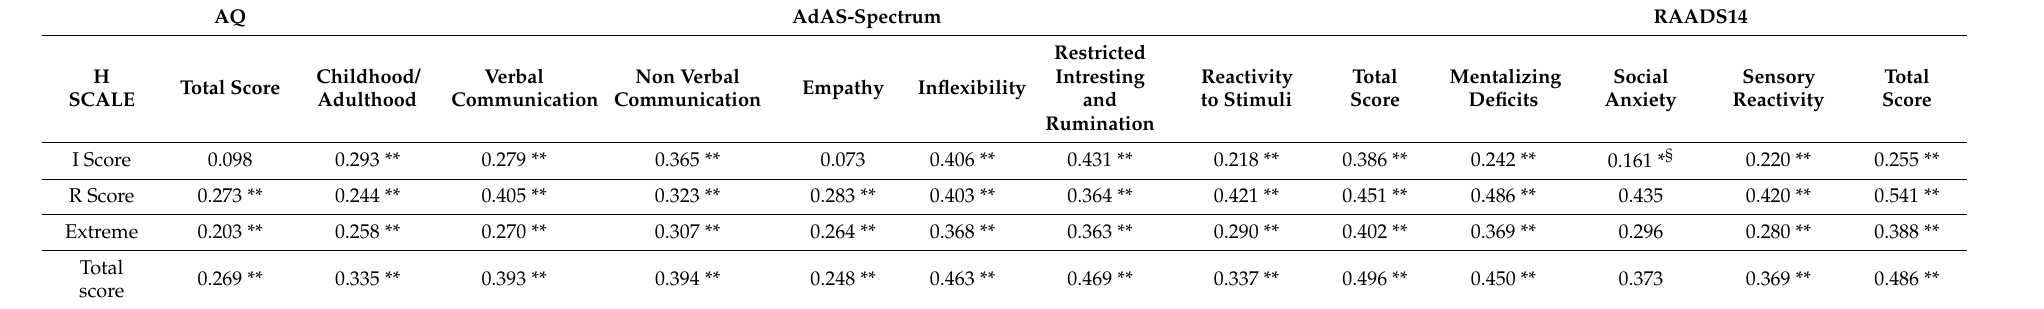
Table 3. Correlation analysis (Pearson correlation) between arousal (H-Scale) and autistic traits (AQ, AdAS-Spectrum and RAADS14) in